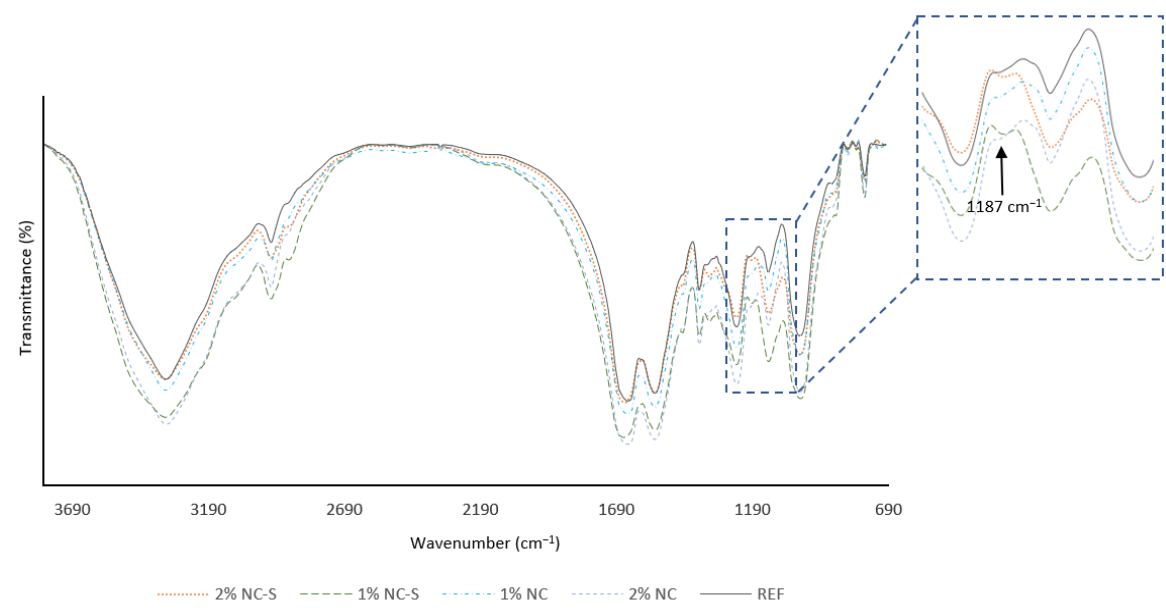
Figure 6. FTIR spectra of adhesive powders.